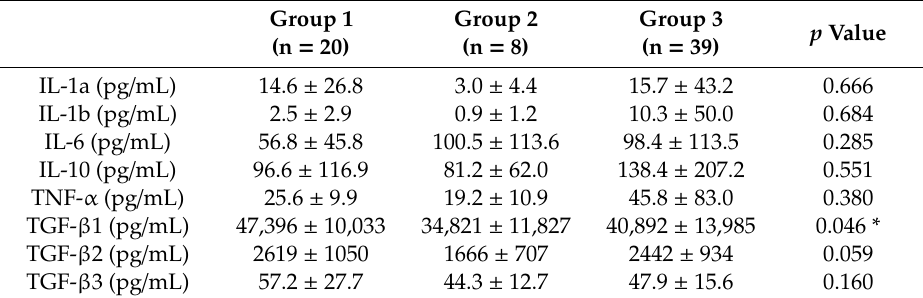
Table 4. Baseline cytokine level before IVIG treatment.